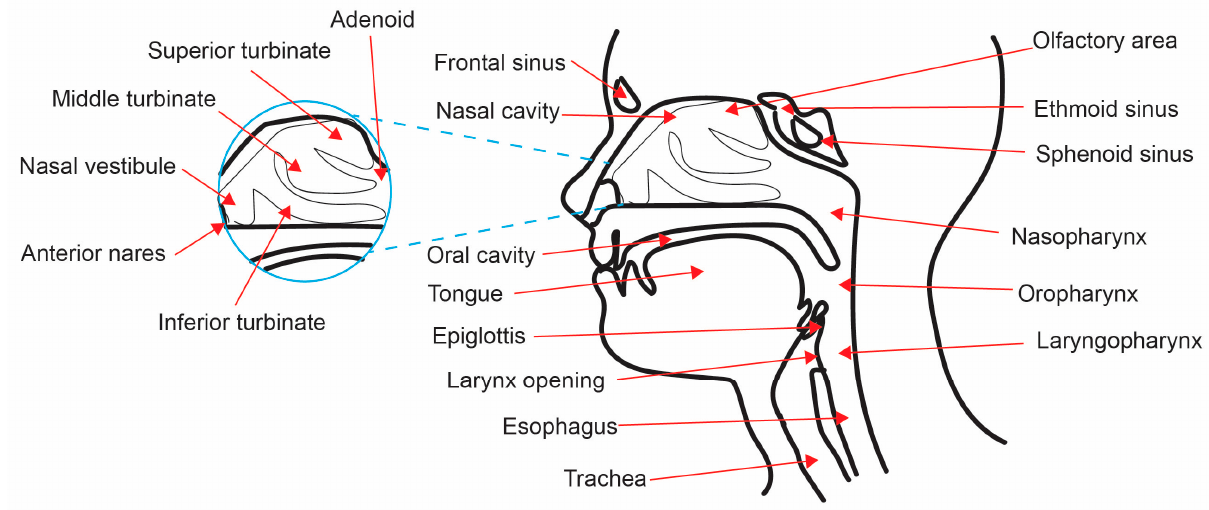
Figure 1. The anatomy of the upper airways. The UAs are formed by many different cavities, including the nasal cavity, sinuses, nasopharynx, oropharynx, and laryngopharynx.